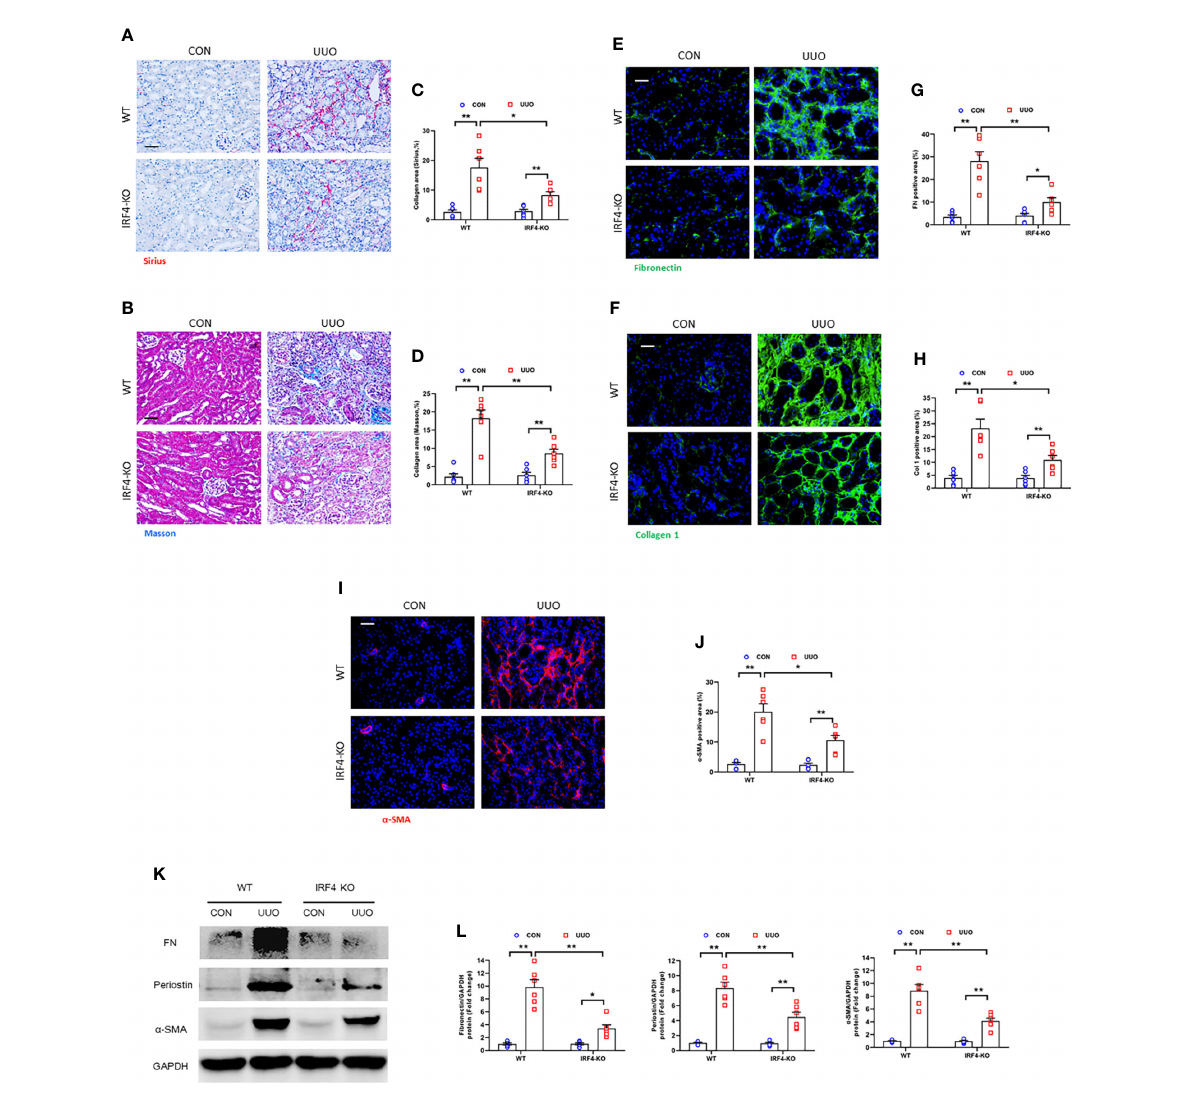
FIGURE 8 IRF4 de fi ciency impedes renal fi brosis, extracellular matrix protein expression, and myo fi broblasts accumulation in obstructive nephropathy. (A, B) Sirius red or Masson ’ s Trichrome staining for kidney sections. (C, D) Quantitative analysis of collagen area in the kidneys. (E, F) Kidney sections were stained with fi bronectin (green) or collagen I (green). (G, H) Quantitative analysis of positive area. (I) Kidney sections were stained for a -SMA (red). (J) Quantitative analysis of a -SMA -positive area. (K) Western blots bands of protein expression of fi bronectin, periostin and a